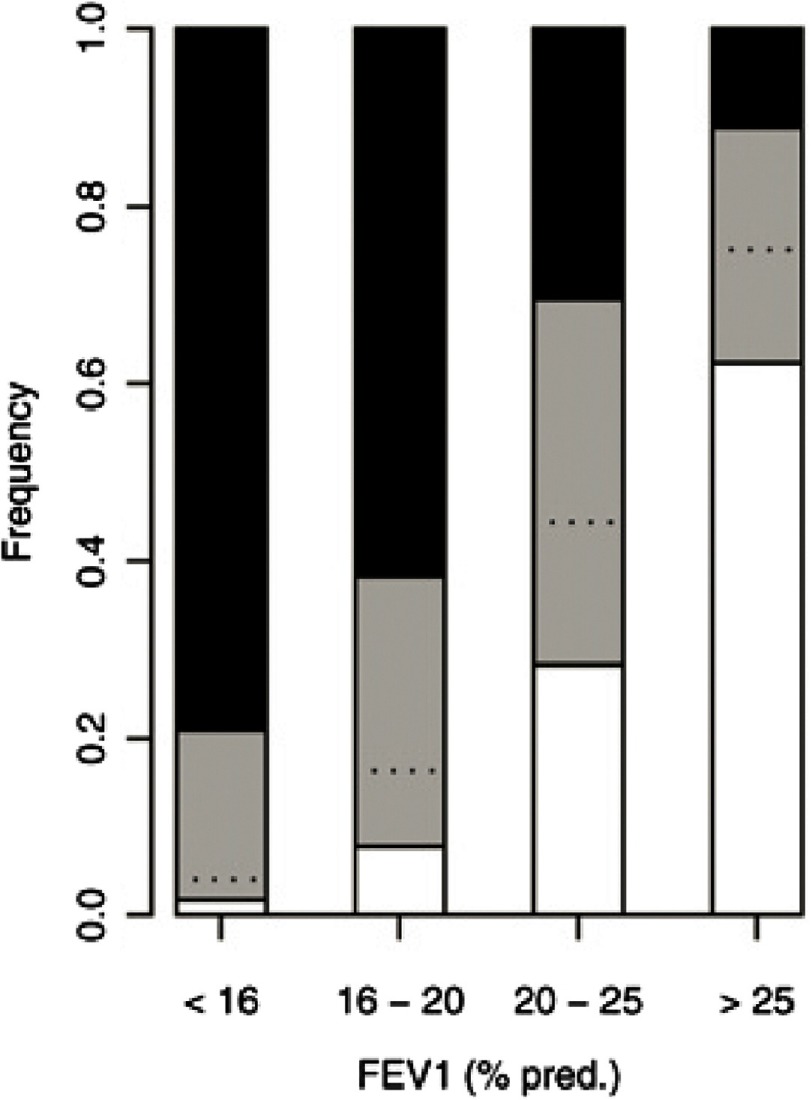
Survival effect of bilateral lung transplant in COPD according to quartiles of FEV1% predicted.Black areas of bars represent difference between expected median survival with and without transplant of > 1 yr (gain of life), white areas a loss of > 1 yr and shaded areas gain or loss of < 1 yr. Dashed lines separate between gain and loss of survival (taken from reference # 41 with permission).